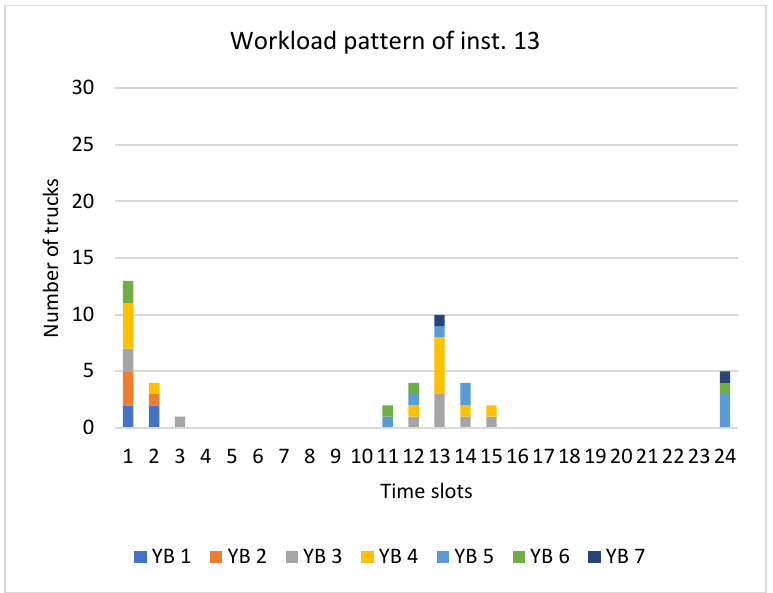
Figure 5. The workload distribution for instance 13.